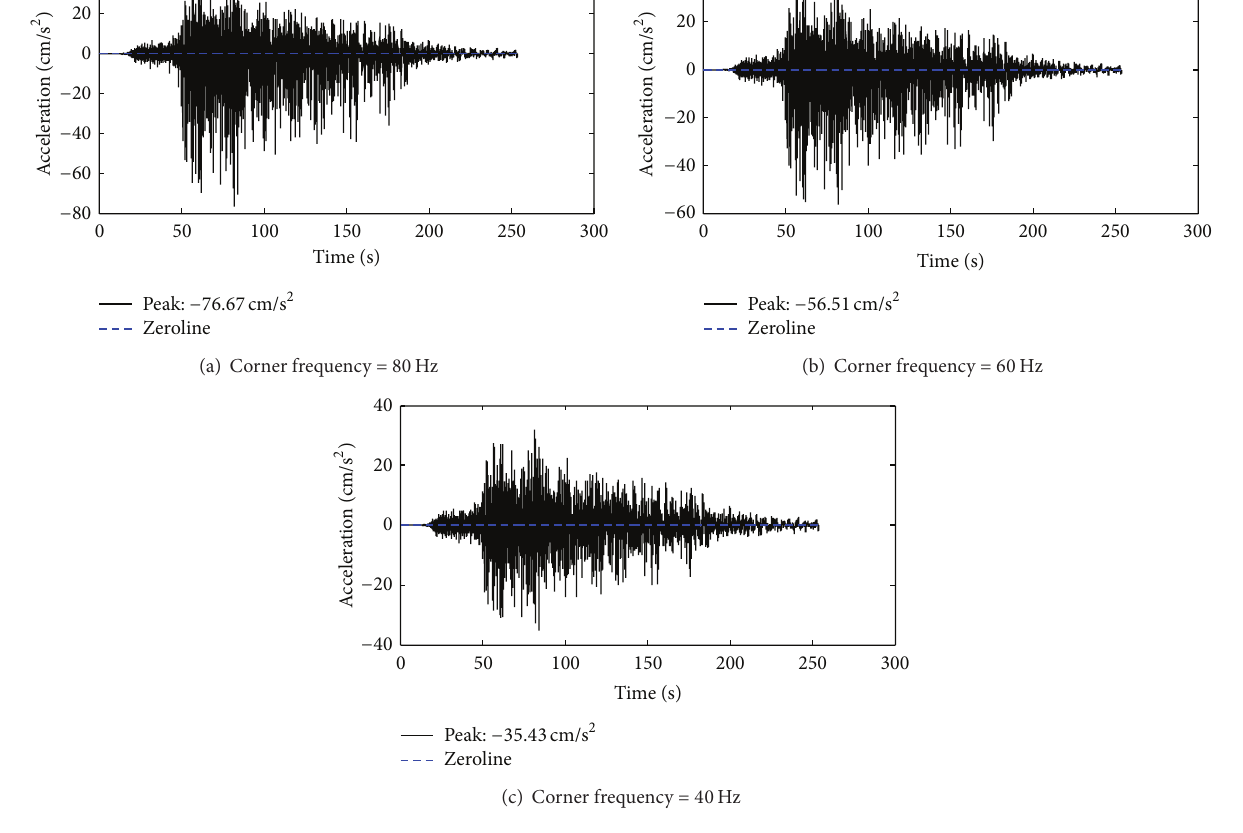
Figure 17: Acceleration time history (UD, after low-pass filtering).